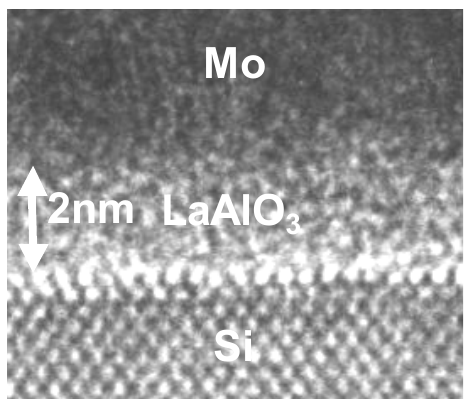
/Si substrate gate stack. 3